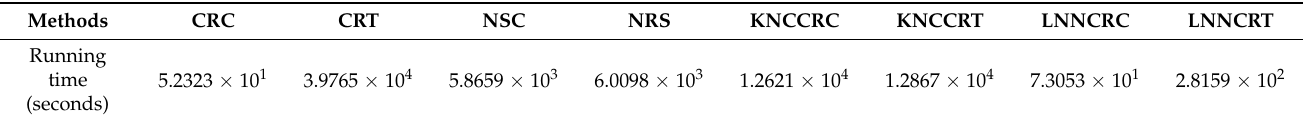
Table 4. Running time of different methods for land cover